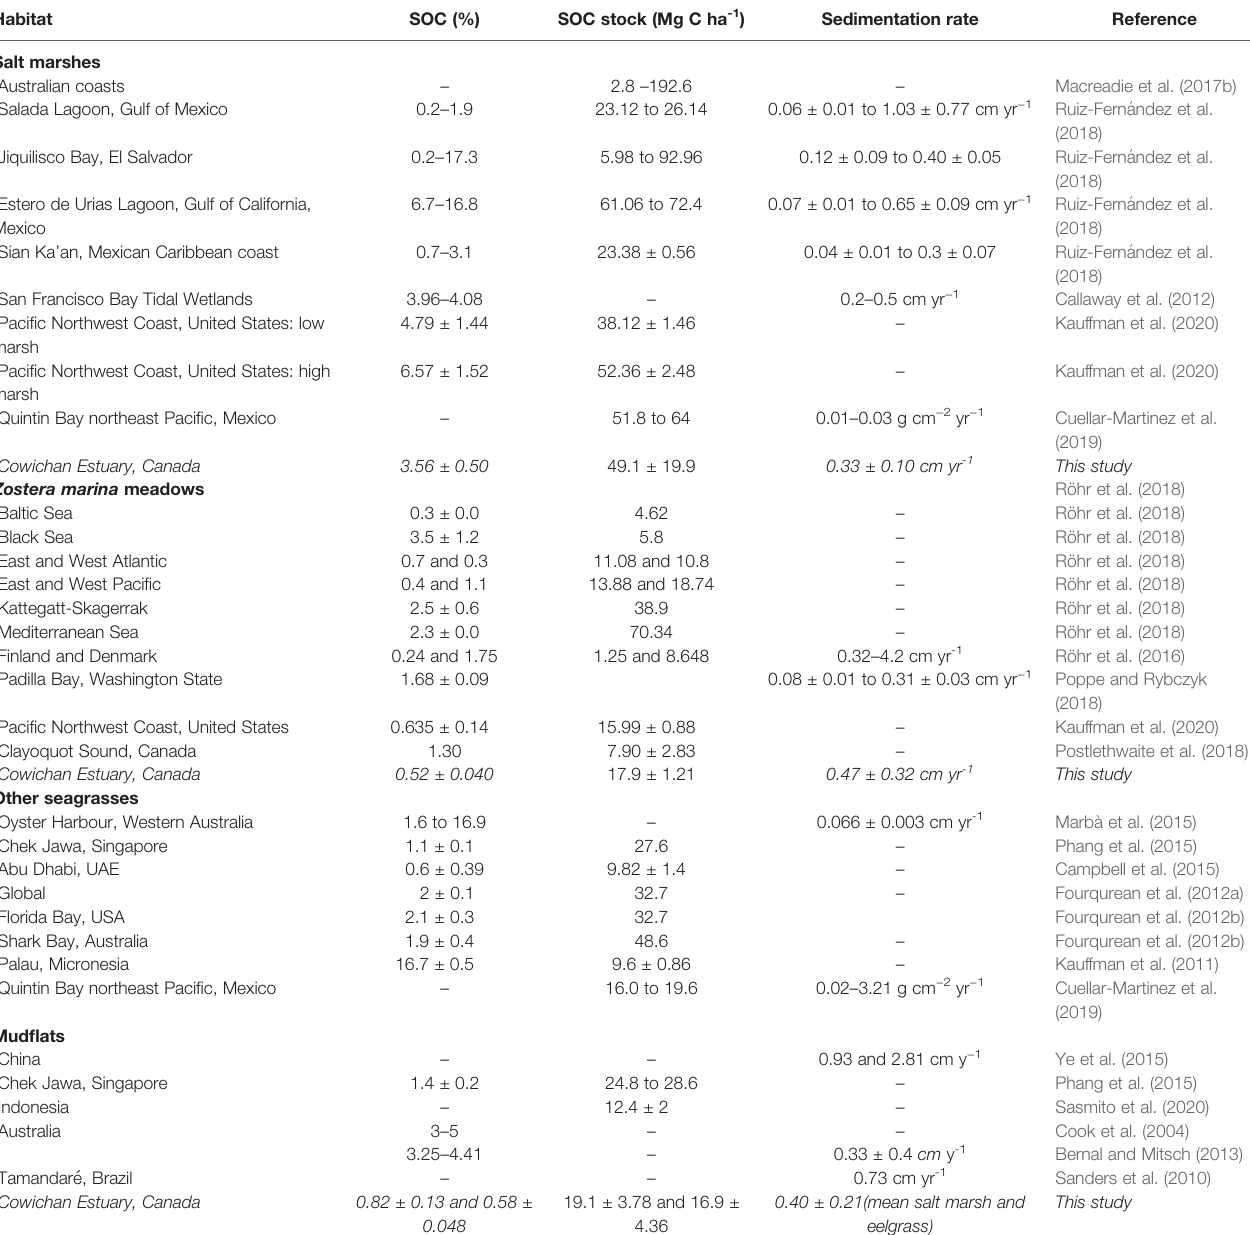
TABLE 1 | Comparison of sediment organic carbon (SOC) concentrations (% by weight) and stocks (Mg C ha − 1 ) at different salt marsh, mud fl at and eelgrass environments.